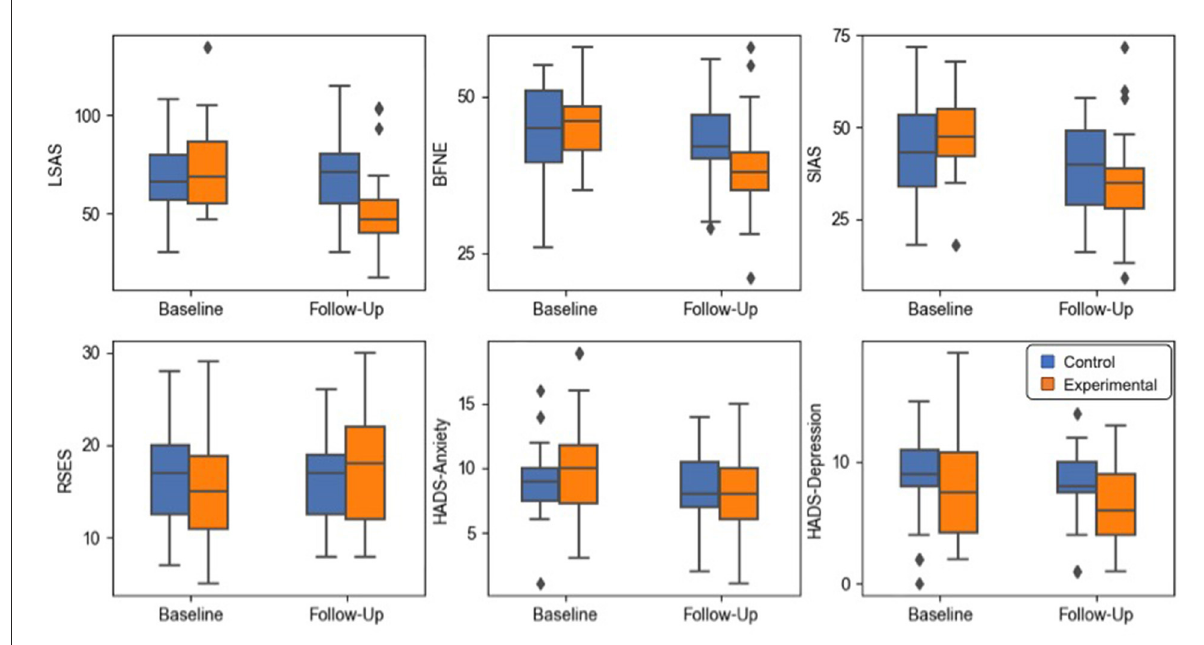
FIGURE2 Box plots of the psychometric scale score results. The whiskers indicate the farthest data from the box within the 1.5 inter-quartile range.